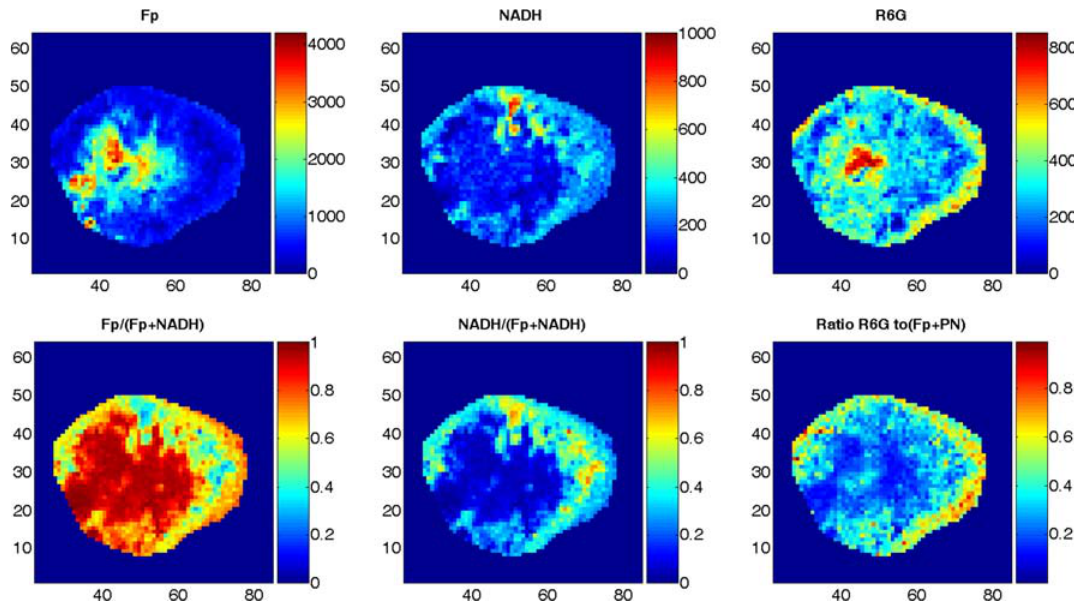
Fig. 4. The typical redox and ROS (labeled with R6G) images of a MDA-MB-231 tumor section. R6G stands for rhodamine 6G which was converted from exogenous dihydrorhodamine 6G bound to mitochondria and oxidized by